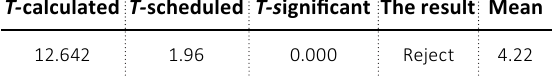
Table 9. Results related to the